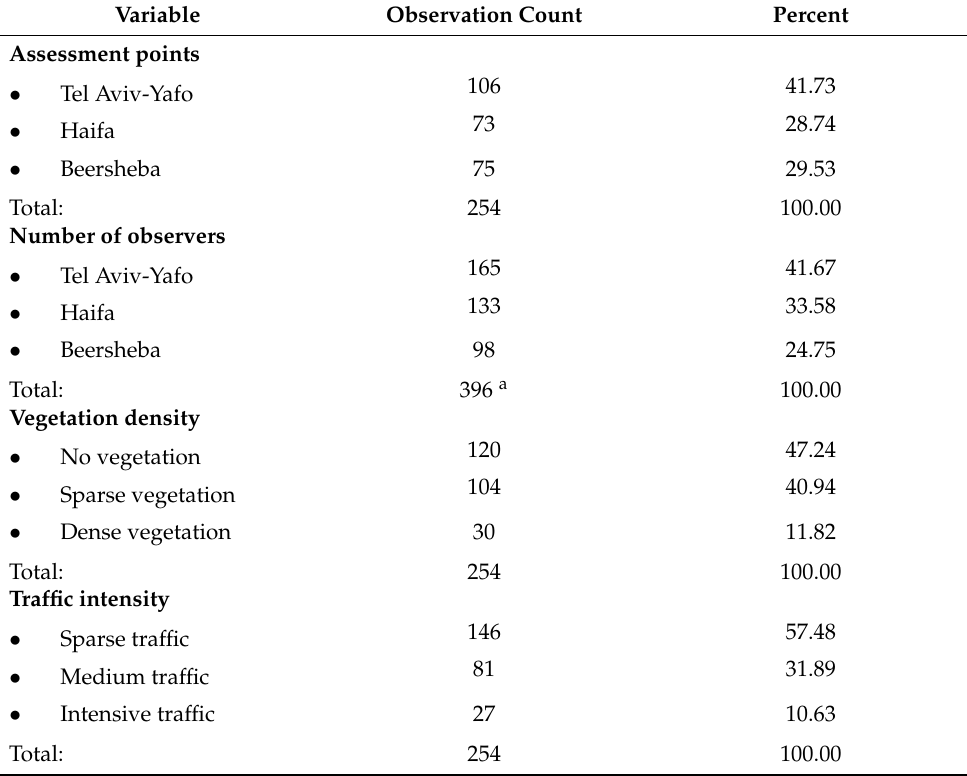
Table A1. Frequency statistics of selected research variables (total number of individual re- ports = 25,662; total number of SL assessment points = 254).